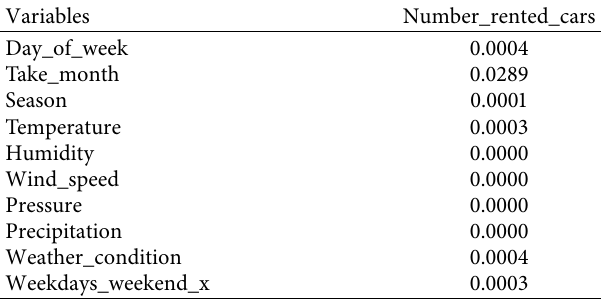
Table 4: Granger causality test results.